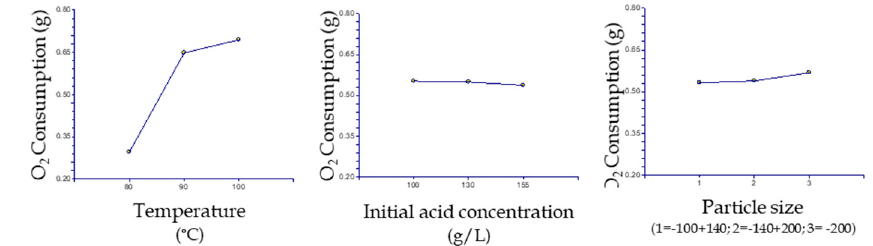
Figure 9. Correlations of temperature, initial acid concentration and particle size with oxygen consumption.